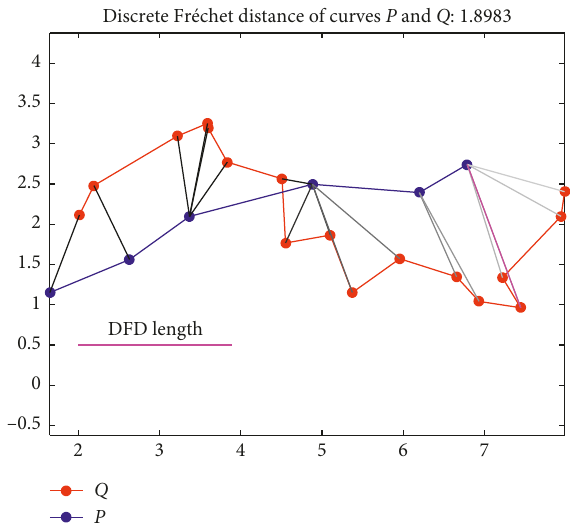
Figure 4: The example of discrete Fr´echet distance.